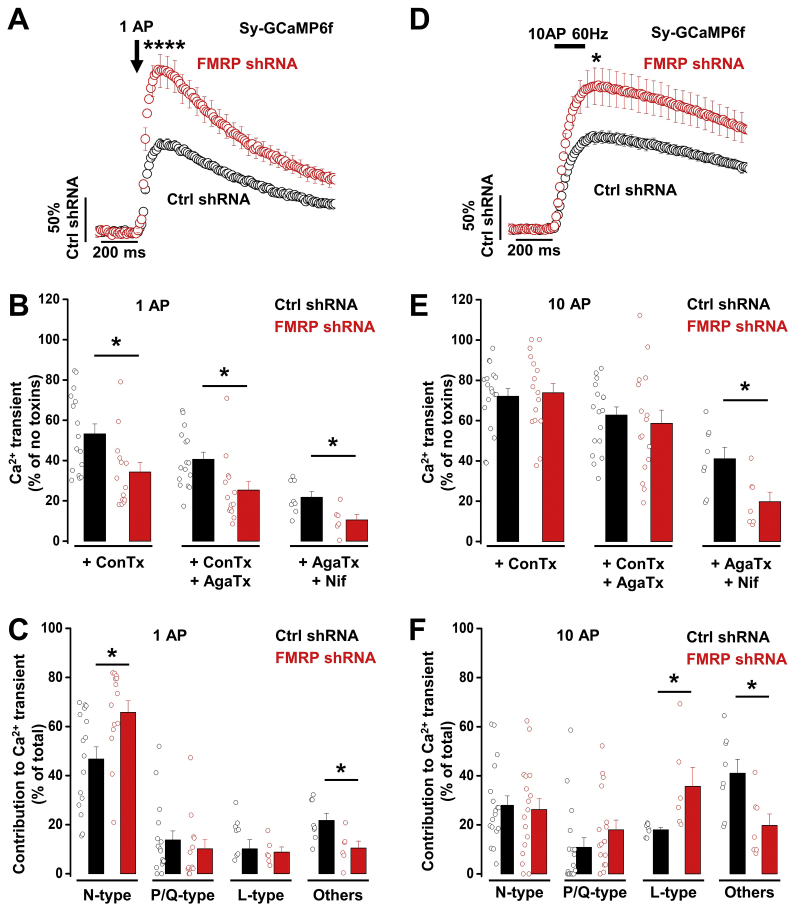
FMRP knock-down increases Ca2+ transients in presynaptic terminals of DRG neurons via N-type calcium channels.A) Average increase of sy-GCaMP6f fluorescence in response to 1 AP recorded from synaptic terminals transfected with either Ctrl shRNA (black circles) or FMRP shRNA (red circles). The Ca2+ transient was expressed as ΔF/F0 and normalized to the averaged peak in the Ctrl shRNA condition. Peak values are 100.0 ± 6.9% (n = 31) and 186.4 ± 17.9% (n = 33, P = .00004) for Ctrl shRNA and FMRP shRNA, respectively. Average sy-GCaMP6f responses (mean ± SEM) to 1 AP correspond to 5–6 trial averages from 25 to 50 boutons. n numbers correspond to independent experiments. ****P < .0001, one-way ANOVA and Bonferroni post-hoc test.B) Effect of sequential application of specific calcium channel blockers on the amplitude of the Ca2+ transient in response to 1 AP. Average Ca2+ transients were normalized to their respective “no toxin” peak in Ctrl shRNA and FMRP shRNA condition. The residual Ca2+ transient in response to 1 AP after treatment with ω-conotoxin GVIA (ConTx, 1 μM; N-type calcium channel blocker) was 53.3 ± 1.9% (n = 16) in Ctrl shRNA and 34.3 ± 4.8% (n = 14, P = .01) in FMRP shRNA. When ω-agatoxin IVA (AgaTx, 300 nM; P/Q-type calcium channel blocker) was added to the perfusion 40.7 ± 3.5% (n = 16) and 25.4 ± 4.3% (n = 14, P = .01) of the Ca2+ transient remained for Ctrl shRNA and FMRP shRNA, respectively. After adding nifedipine (Nif, 10 μM; L-type calcium channel blocker) to the perfusion, the remaining Ca2+ transient was 21.7 ± 2.9% (n = 8) and 10.5 ± 2.8% (n = 6, P = .016) for Ctrl shRNA and FMRP shRNA, respectively. Average sy-GCaMP6f responses (mean ± SEM) to 1 AP correspond to 5–6 trial averages from 25 to 50 boutons. n numbers correspond to independent experiments. * P < .05, one-way ANOVA and Bonferroni post-hoc test.C) Respective contribution of voltage-gated calcium channels to the Ca2+ transient in response to 1 AP in presynaptic terminals of DRG neurons. In the Ctrl shRNA condition, N-type, P/Q-type, L-type channels and other types contribute to 46.7 ± 4.9% (n = 16), 13.8 ± 3.7% (n = 16), 15.7 ± 2.8% (n = 8) and 21.7 ± 2.9% (n = 8), respectively. In FMRP shRNA condition, N-type, P/Q-type, L-type channels and other types contribute to 65.7 ± 4.8% (n = 14, P = .01), 10.1 ± 3.7% (n = 13, P = .49), 8.9 ± 2.1% (n = 6, P = .09) and 10.5 ± 2.8% (n = 6, P = .016), respectively. n numbers correspond to independent experiments. * P < .05, one-way ANOVA and Bonferroni post-hoc test.D) Average increase of sy-GCaMP6f fluorescence in response to 10 APs at 60 Hz, recorded from synaptic terminals transfected with either Ctrl shRNA (black circles) or FMRP shRNA (red circles). Ca2+ transient was expressed as ΔF/F0 and normalized to the averaged peak in the Ctrl shRNA condition. Peak values are 100.0 ± 7.0% (n = 31) and 150.0 ± 19.0% (n = 34, P = .02) for Ctrl shRNA and FMRP shRNA, respectively. Average sy-GCaMP6f responses (mean ± SEM) to 1 AP correspond to 5–6 trial averages from 25 to 50 boutons. n numbers correspond to independent experiments. *P < .02, one-way ANOVA and Bonferroni post-hoc test.E) Effect of specific calcium channel blocker application on the amplitude of the Ca2+ transient in response to 10 AP at 60 Hz. The remaining Ca2+ transient after treatment with ConTx GVIA was 72.1 ± 3.8% (n = 18) in Ctrl shRNA and 73.8 ± 4.6% (n = 17, P = .77) in FMRP shRNA. After application of AgaTx the remaining Ca2+ transient was 62.8 ± 4.0% (n = 18) and 58.7 ± 6.5% (n = 16, P = .59) for Ctrl shRNA and FMRP shRNA, respectively. After application of Nif, the remaining Ca2+ transient was 41.0 ± 5.7% (n = 8) and 19.8 ± 4.7% (n = 7, P = .013) for Ctrl shRNA and FMRP shRNA, respectively. n numbers correspond to independent experiments. * P < .05, one-way ANOVA and Bonferroni post-hoc test.F) Respective contribution of voltage-gated calcium channels to the Ca2+ transient in response to 10 AP at 60 Hz in presynaptic terminals of DRG neurons. In Ctrl shRNA condition, N-type, P/Q-type, L-type channels and other types contribute to 27.9 ± 3.8% (n = 18), 10.8 ± 3.9% (n = 17), 18.0 ± 1.0% (n = 7) and 41.0 ± 5.7% (n = 8), respectively. In FMRP shRNA condition, N-type, P/Q-type, L-type channels and other types contribute to 26.2 ± 4.6% (n = 17, P = .77), 17.9 ± 4.0% (n = 16, P = .21), 35.7 ± 7.7% (n = 6, P = .03) and 19.8 ± 4.7% (n = 6, P = .013), respectively. n numbers correspond to independent experiments. * P < .05, one-way ANOVA and Bonferroni post-hoc test.Open circles (black and red) represent individual experiments. (For interpretation of the references to color in this figure legend, the reader is referred to the web version of this article.)